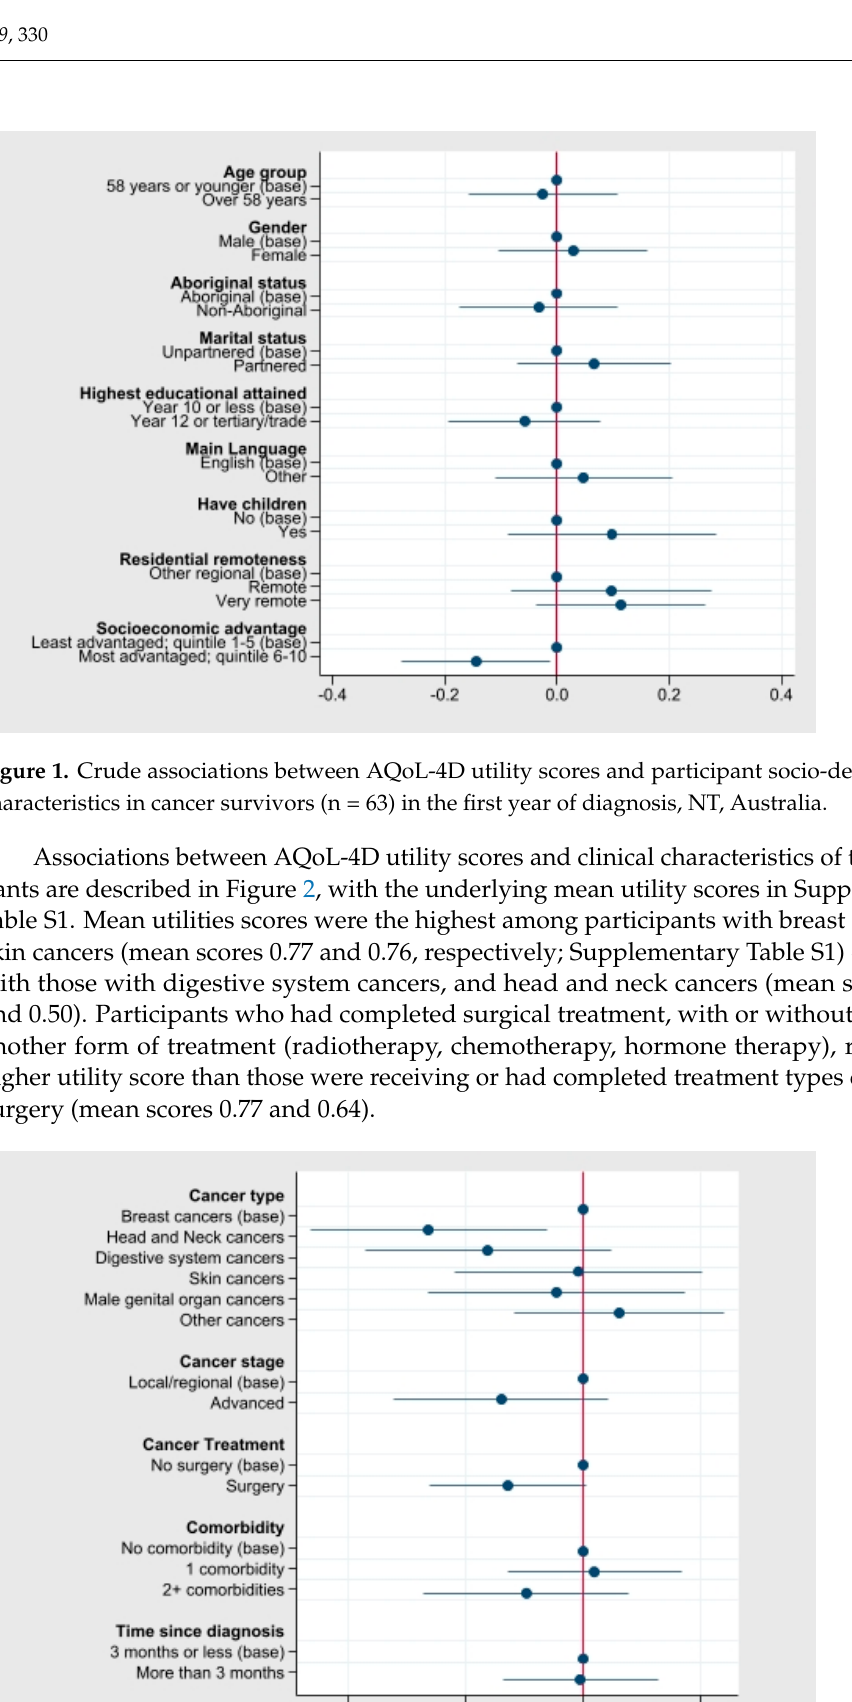
Figure 2. Crude associations between AQoL-4D utility scores and participant clinical characteristics in cancer survivors (n = 63) in the first year of diagnosis, NT, Australia.